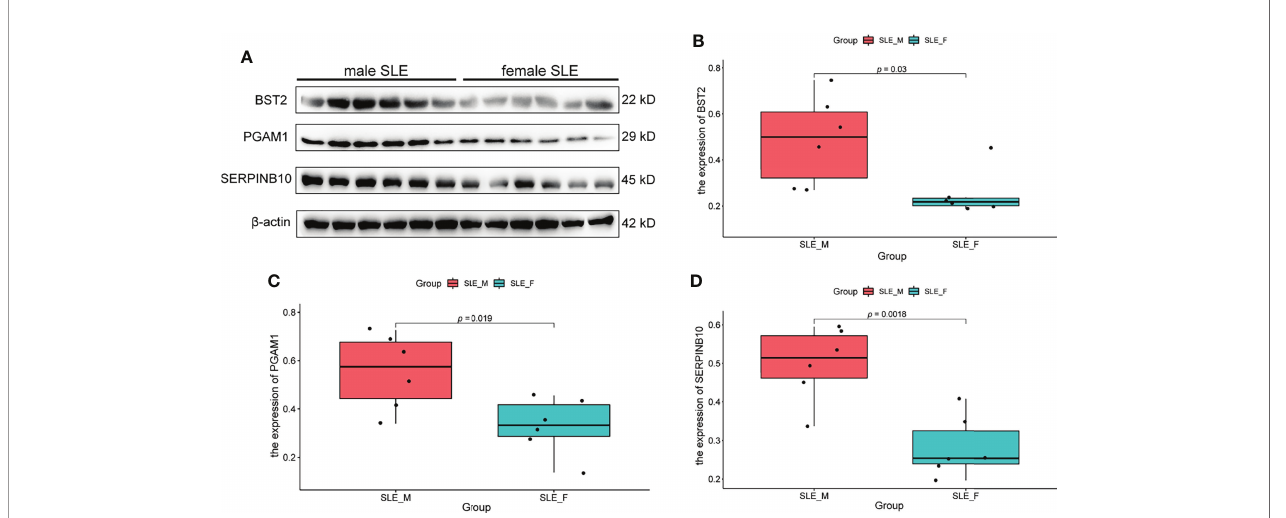
FIGURE 6 | Western Blot Validation of Proteins in Neutrophil Activation Networks. (A) Western blot analysis of BST2, PGAM1 and SERPINB10 in male SLE and female SLE. (B) Boxplot showing gray value of BST2 in male SLE and female SLE. (C) Boxplot showing gray value of PGAM1 in male SLE and female SLE. (D) Boxplot showing gray value of SERPINB10 in male SLE and female